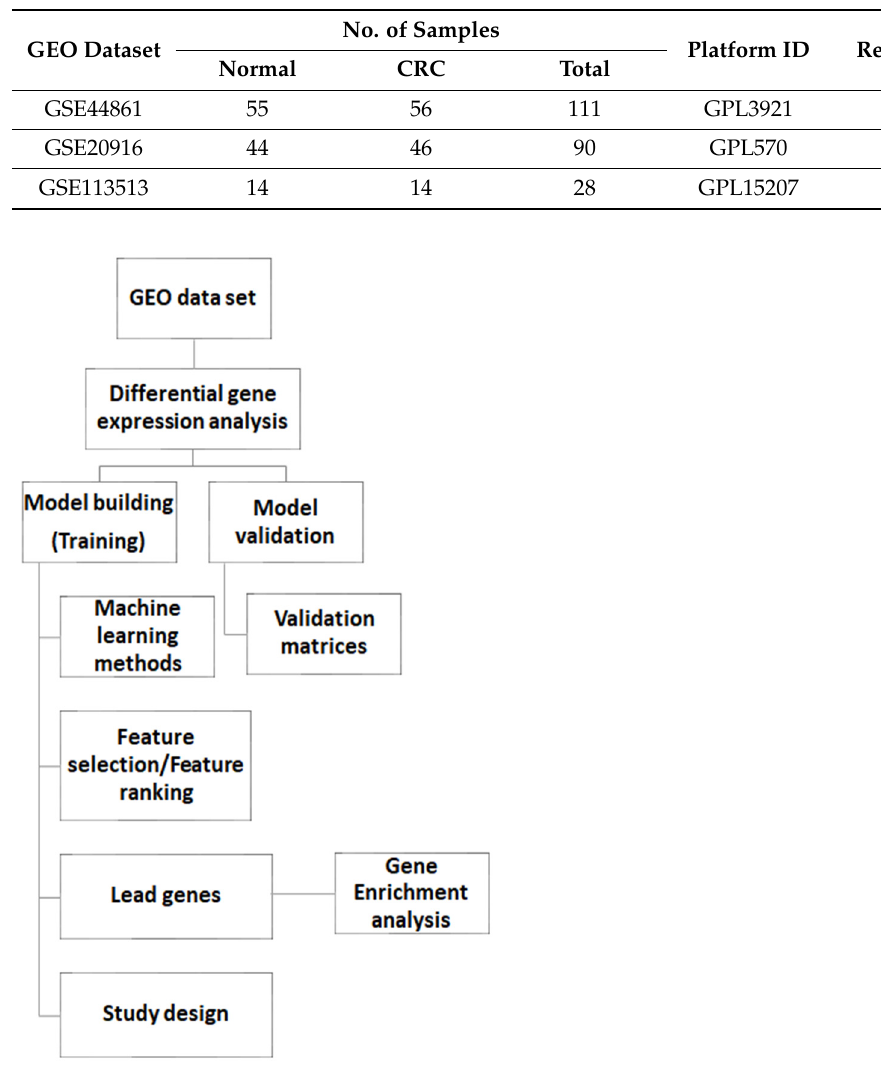
Figure 1. A schematic representation of the biomarker identification workflow. Differentially Expressed Genes (DEGs) Identified by GEO2R GEO2R (http://www.ncbi.nlm.nih.gov/geo/geo2r, accessed on 5 January 2021), an online data analysis tool, was used to identify differentially expressed genes (DEGs) be- tween colon cancer patients and healthy controls. We used three GEO series, namely GSE20916, GSE44861, and GSE113513, and identified differential expressed genes. Genes without a corresponding gene symbol and genes with more than one probe set were re- moved. Adjusted p -values ≤ 0.0001 were considered statistically significant. Subsequently, the top 500 most statistically significant DEG genes from each dataset were selected for further